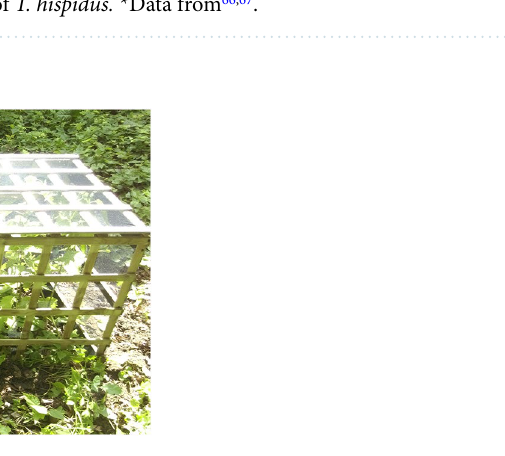
Table 1. Characteristics of sampling localities of T. hispidus. *Data from 66,67 .